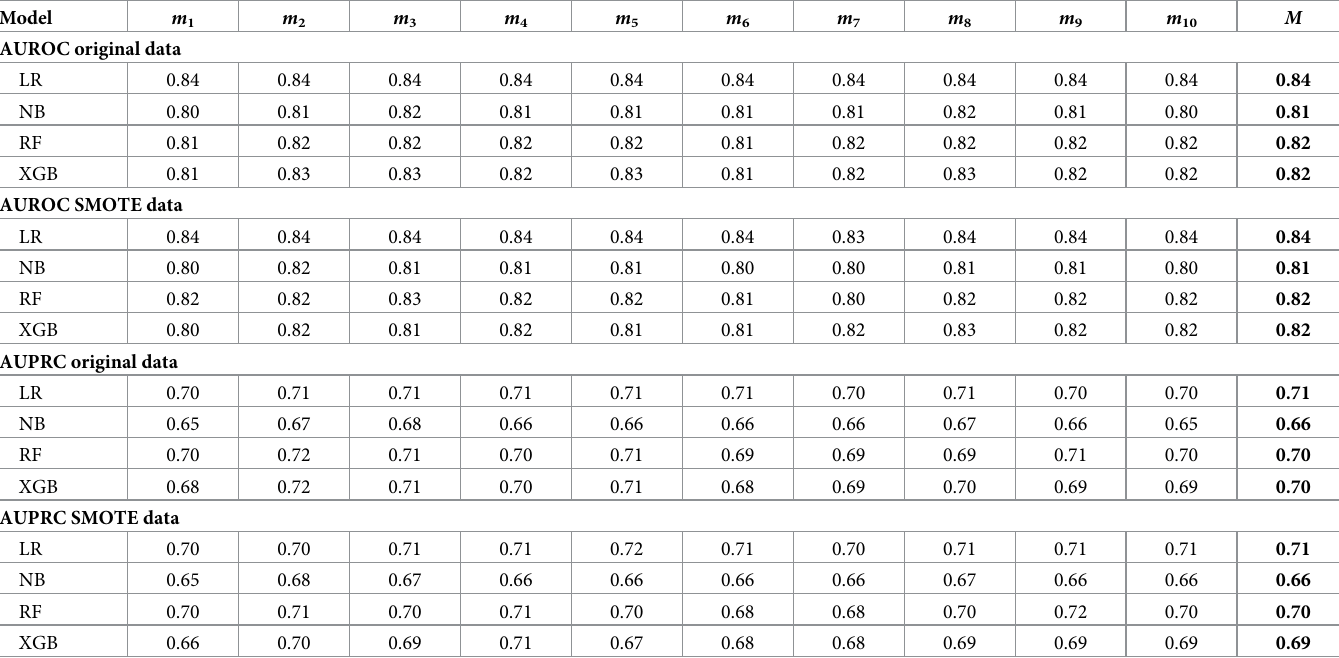
AUROC: area under the receiver operating characteristics curve; AUPRC: area under the precision-recall curve; LR: logistic regression; NB: naive bayes; RF: random forest; XGB: extreme gradient boosting; SMOTE: synthetic minority oversampling technique; Each different replica from the dataset is represented by m n , and M represents the combination of estimates obtained for observations in every